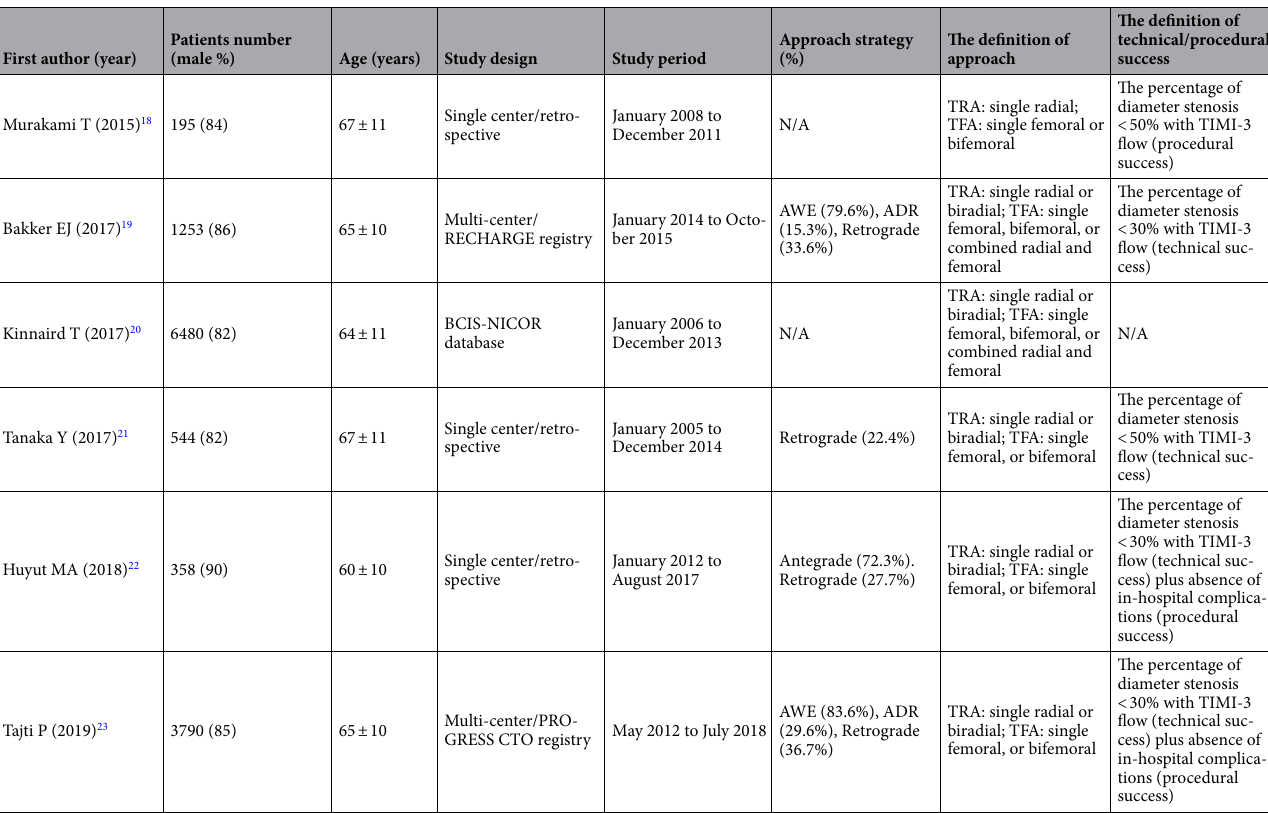
Table 1. Characteristics of the 6 included studies. AWE antegrade wire escalation, ADR antegrade dissection and re-entry, TIMI thrombolysis in myocardial